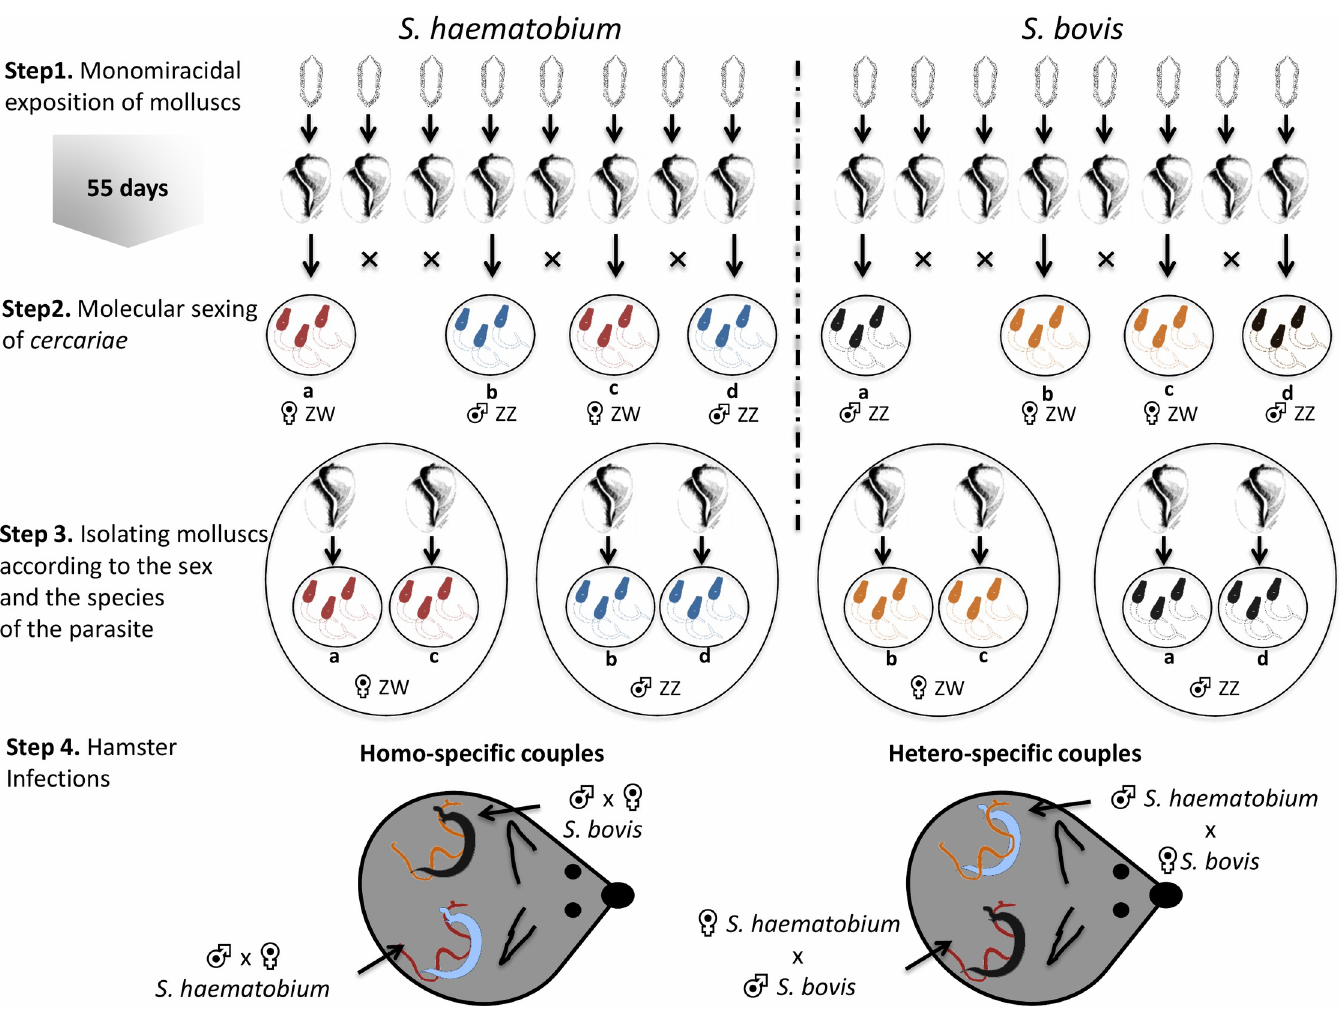
Fig 1. Schematic representation of experimental infection